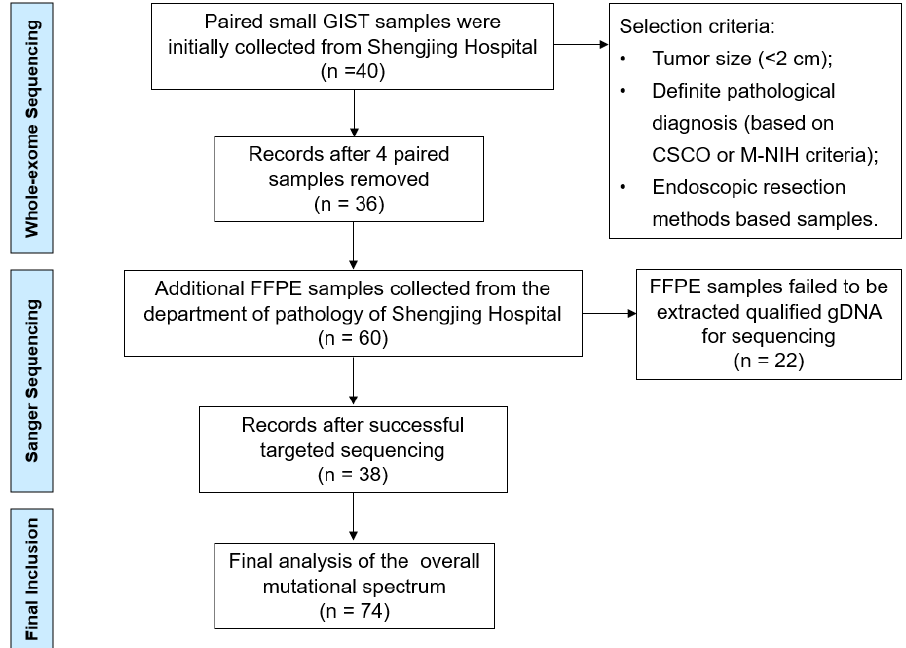
Figure 1. Flow chart of the selection procedure.